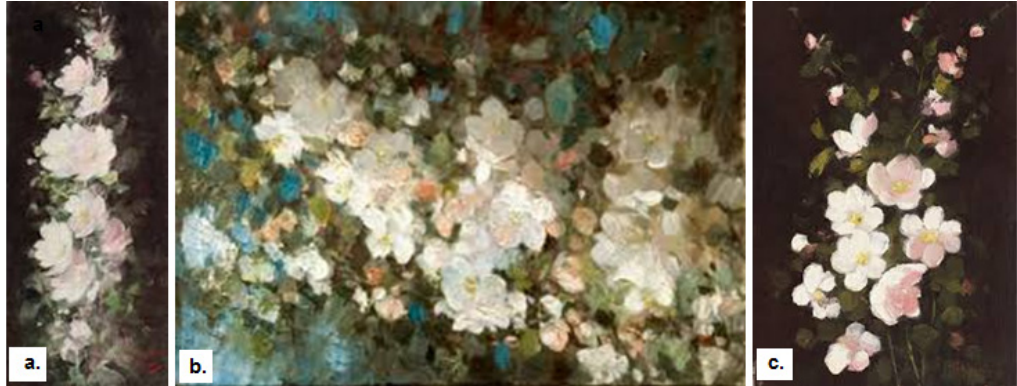
Figure 4. Paintings depicting apple flowers, painted by Nicolae Grigorescu, from three private collections: ( a ). “Apple flowers” (1863–1865), oil on wood (310 × 135 mm); ( b ) “Apple flowers” (1903–1904), oil on wood (235 × 140 mm); ( c ) “Apple flowers” (1867–1869), oil on cardboard (230 × 160 mm).